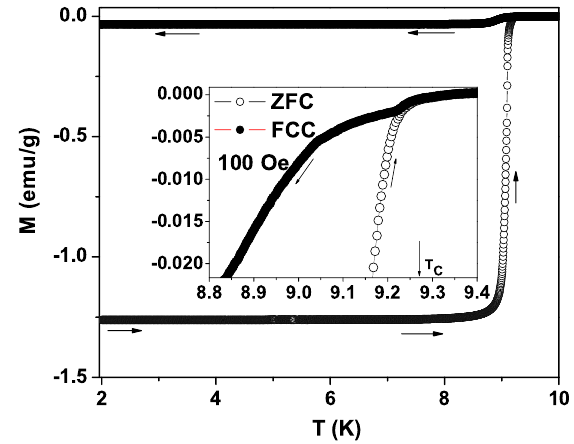
FIG. 6. M versus T plot for electron beam welded and electro- polished niobium butt joint in an applied field of 100 Oe. The inset highlights the temperature region near T C . FIG. 7. M versus T plot for electropolished as-received niobium in an applied field of 100 Oe. The inset highlights the temperature region near T C .